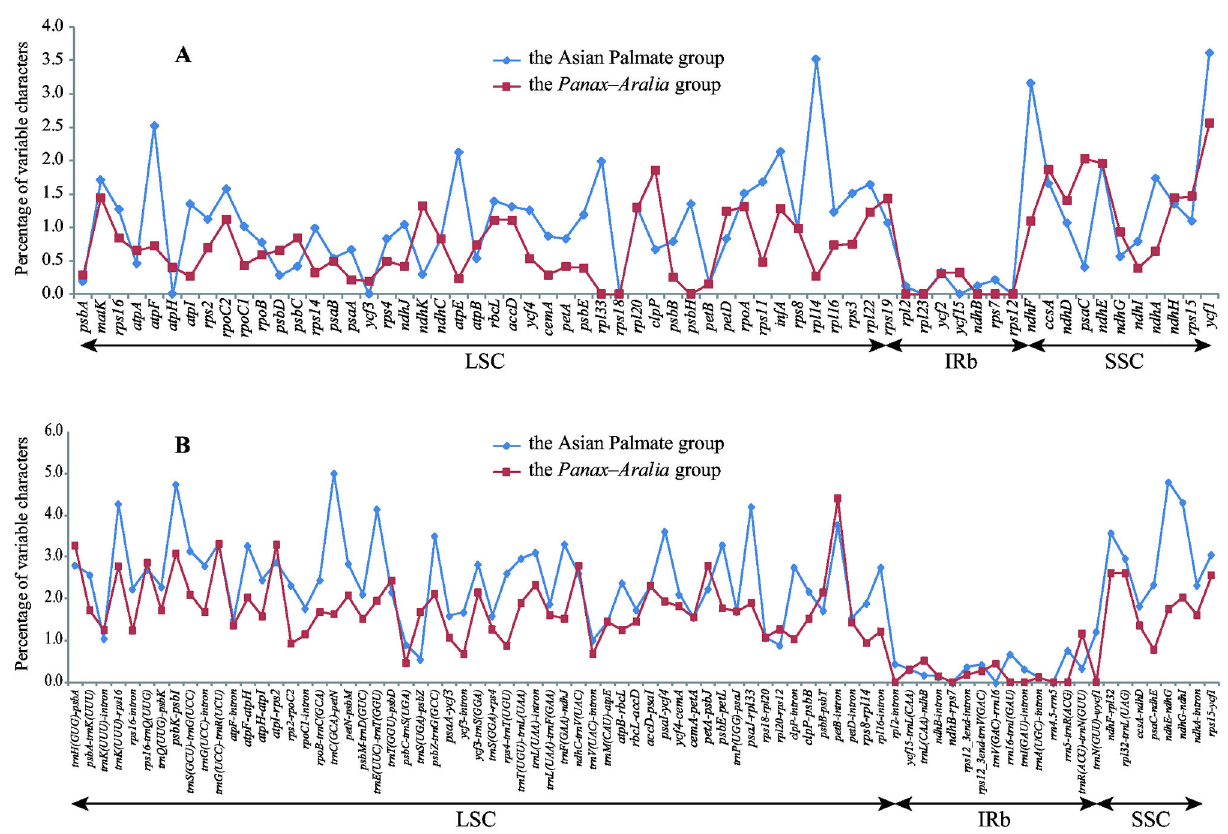
Figure 7. Percentage of variable characters in homologous regions between the chloroplast genomes of the Asian Palmate group and the Panax-Aralia group. A: Coding region; B: Noncoding region. The homologous regions are oriented according to their locations in the chloroplast